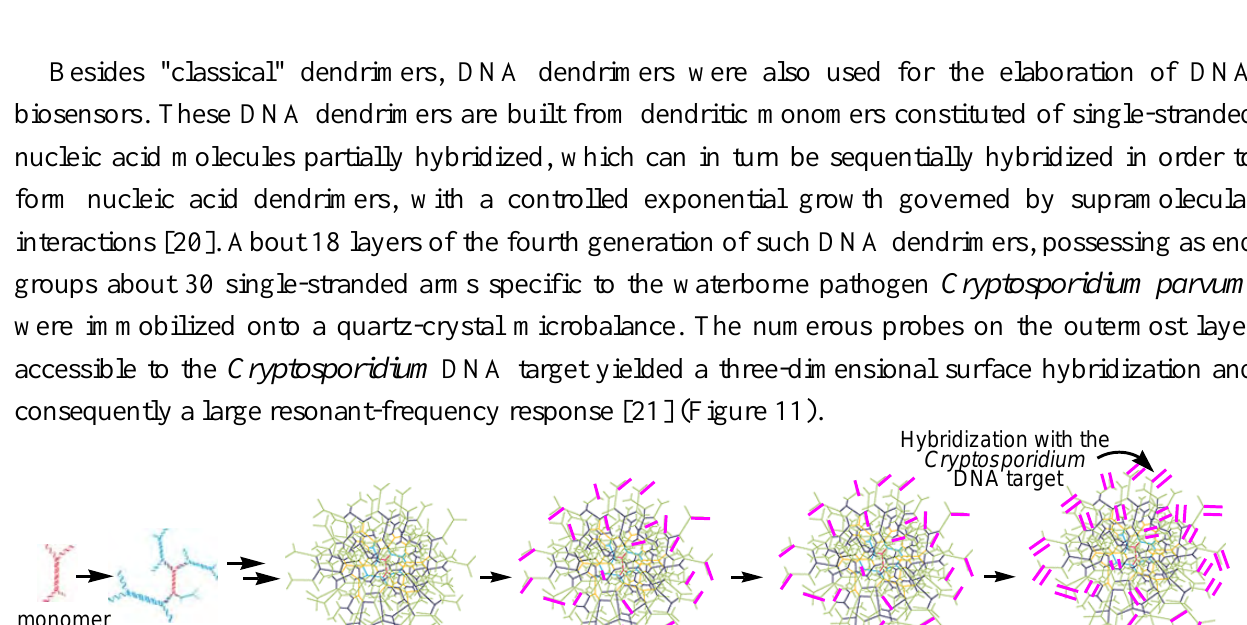
Figure 10. Left: schematic representation of biotinylated oligonucleotides hybridized to complementary oligonucleotides linked to a piezoelectric membrane through the Gc dendrimer; supramolecular recognition of streptavidin-conjugated gold colloid by biotin. Right: resonant frequencies measured before and after the grafting of gold colloids to the piezoelectric membrane.